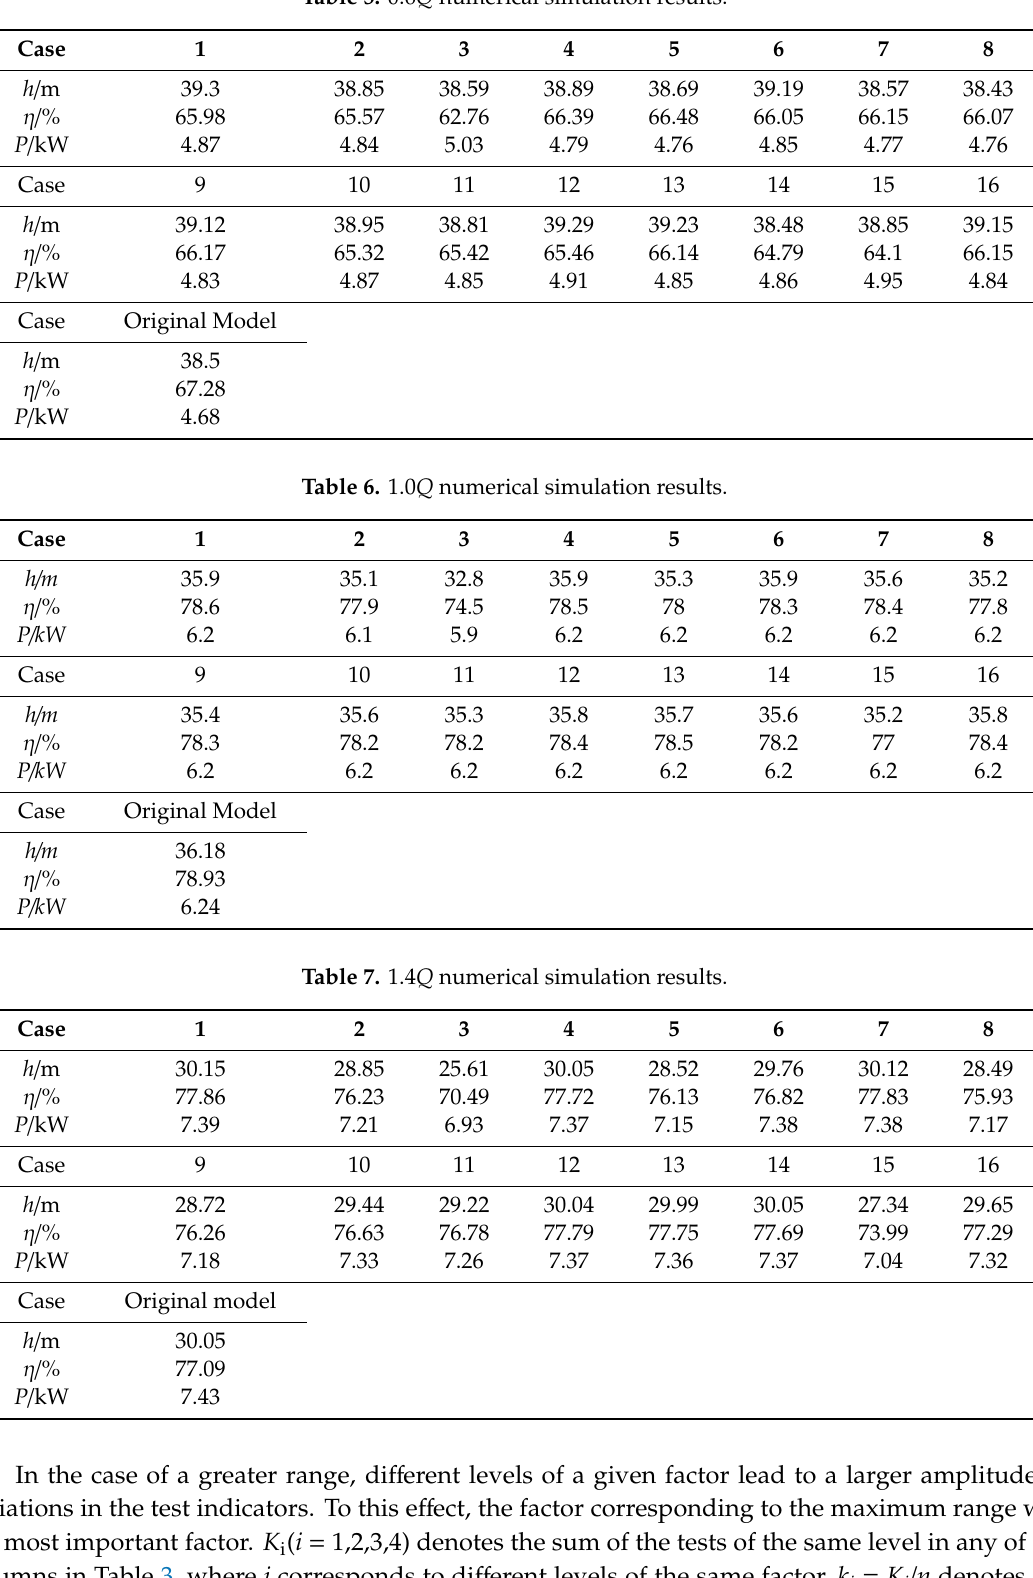
Table 5. 0.6 Q numerical simulation results.